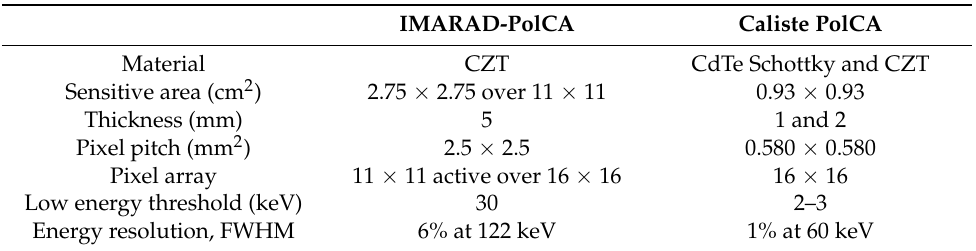
Table 1. Summary of the main characteristics of the two pixels CZT/CdTe detectors used in recent PolCA experiments.